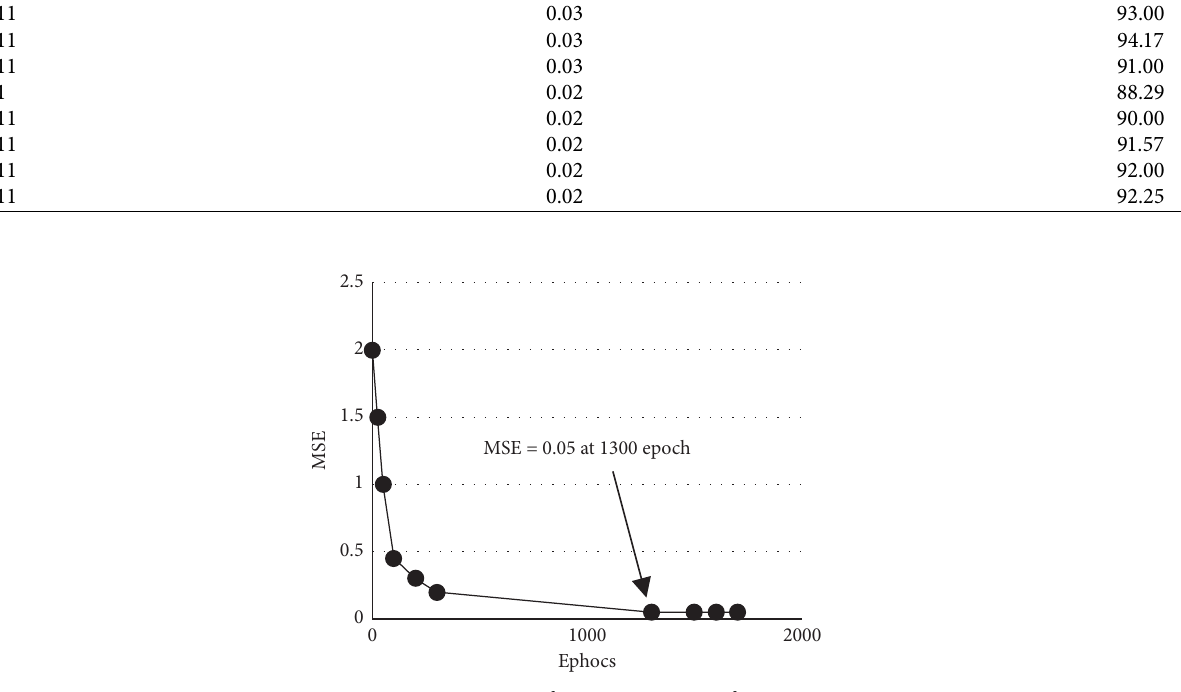
Figure 11: Variation of MSE in training of ANN. Table 4: Ranking-based feature selection using ReliefF